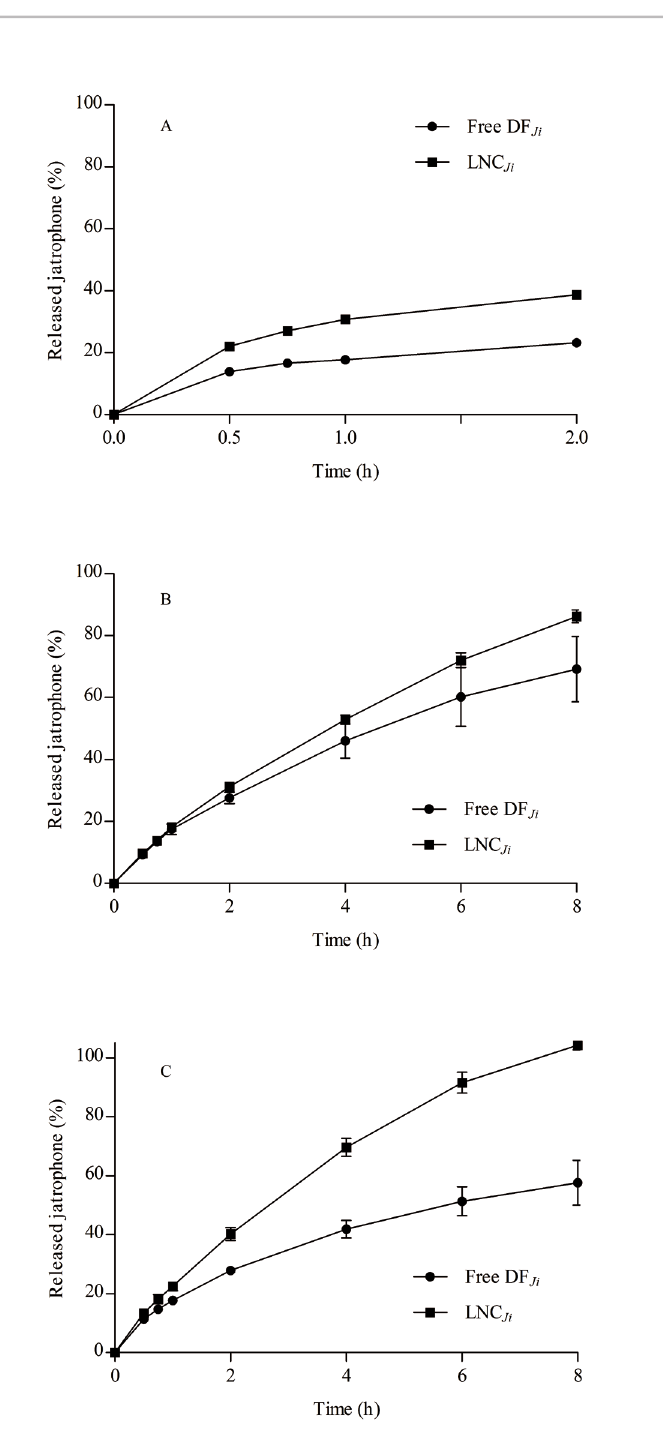
FIGURE 3 - In vitro jatrophone release (± s.d.) from LNC media, (B) fasted state simulated intestinal fluid (FaSSIF) media, and (C) fed state simulated intestinal fluid (FeSSIF), all at 37 °C